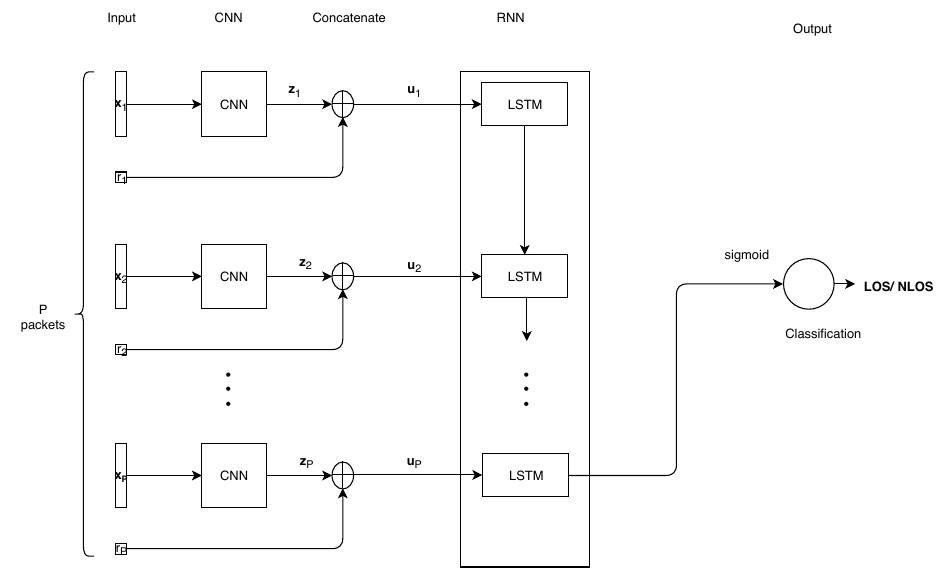
Figure 2. The overall framework of the proposed